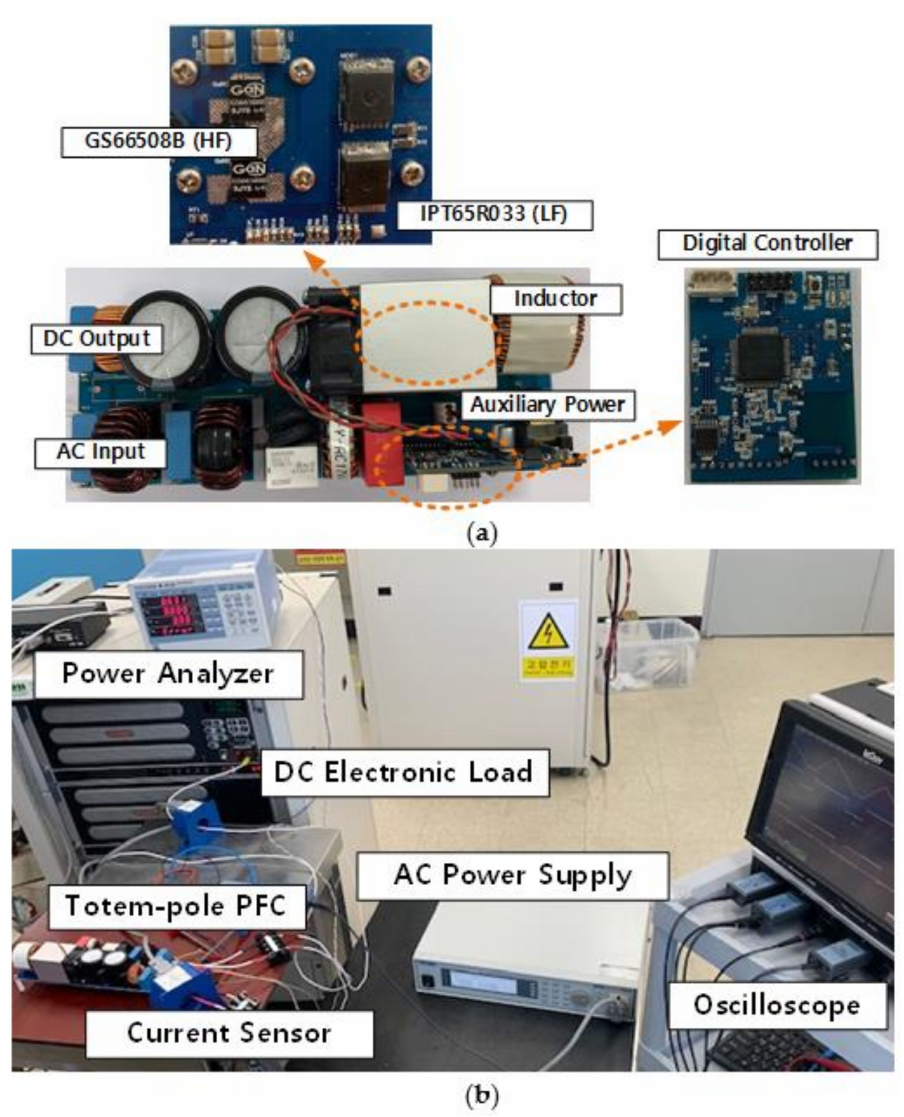
Figure 8. Experiment environment of digital control-based totem Pole PFC. ( a ) prototype of totem- pole PFC using GaN transistor and ( b ) experimental configuration of test bench. Table 2. Specifications and circuit parameters of the totem-pole